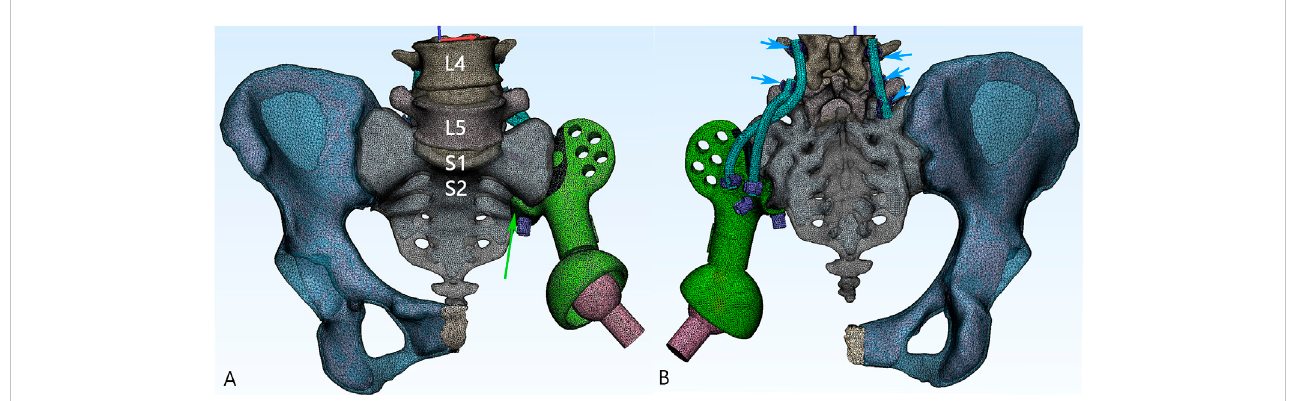
FIGURE 1 3D model of the reconstructive system. (A) The anteroposterior view of the model. Green: the main body of the prosthesis. Pink: the arti fi cial femoral head. Green arrow: the sacral tray structure. (B) The posterior aspect of the model. The screws being fi xed on the prosthesis are de fi ned as sacral screws (purple). Lumbosacral rods (blue) are fi xed with fi ve pedicle screws (short blue arrow).